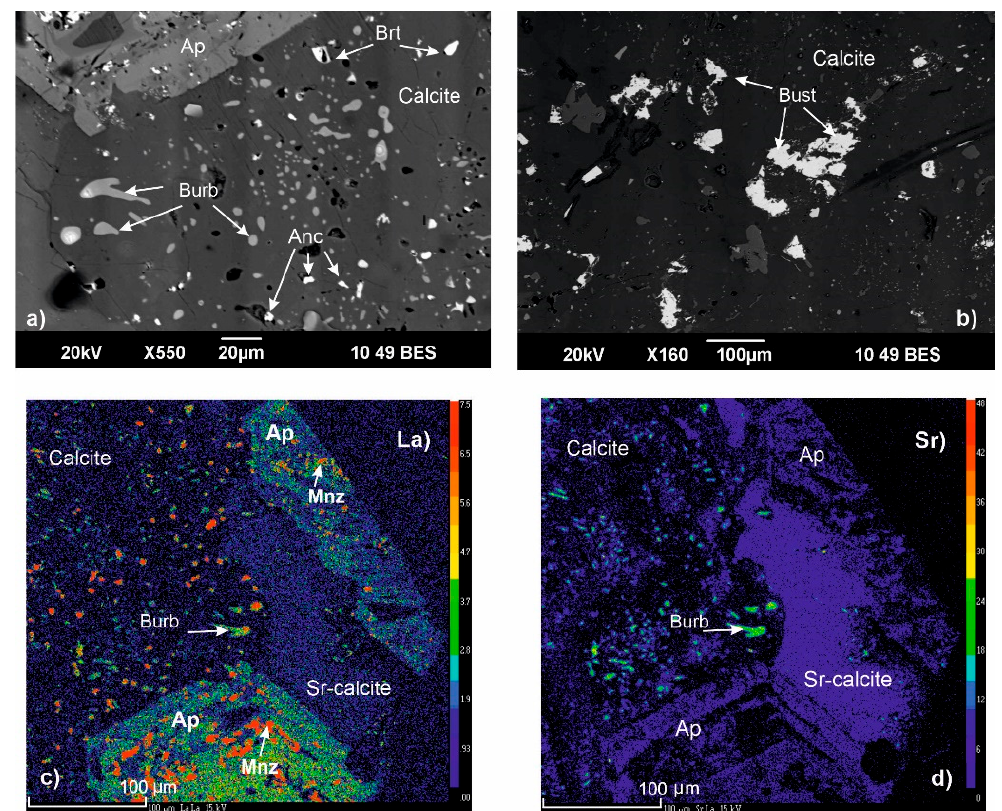
Figure 4. REE-Sr-carbonates and monazites in carbonatites of the Chetlassky complex, Middle Timan. ( a , b ) Images in back-scattered electrons (BSE): ( a ) ingrowths of burbankite (gray), ankylite (light gray) and barite (bright white grains) in calcite; ( b ) segregation of bastnäsite (white) in late carbonate veinlets intersecting grains of early Sr-REE-calcite; ( c , d ) X-ray images: ( c ) La, ( d ) Sr. On the right in both images—high-strontium calcite (5.44% SrO, 0.44% BaO, 0.23% La 2 O 3 ), on the left—low-strontium calcite (1.0% SrO, 0.69% BaO, 0.01% La 2 O 3 ) with ankylite and burbankite intergrowths, below—apatite grain with inclusions of monazite. Ap—apatite, Mnz—monazite, Burb—burbankite, Anc—ankylite, Bust—bastnäsite,